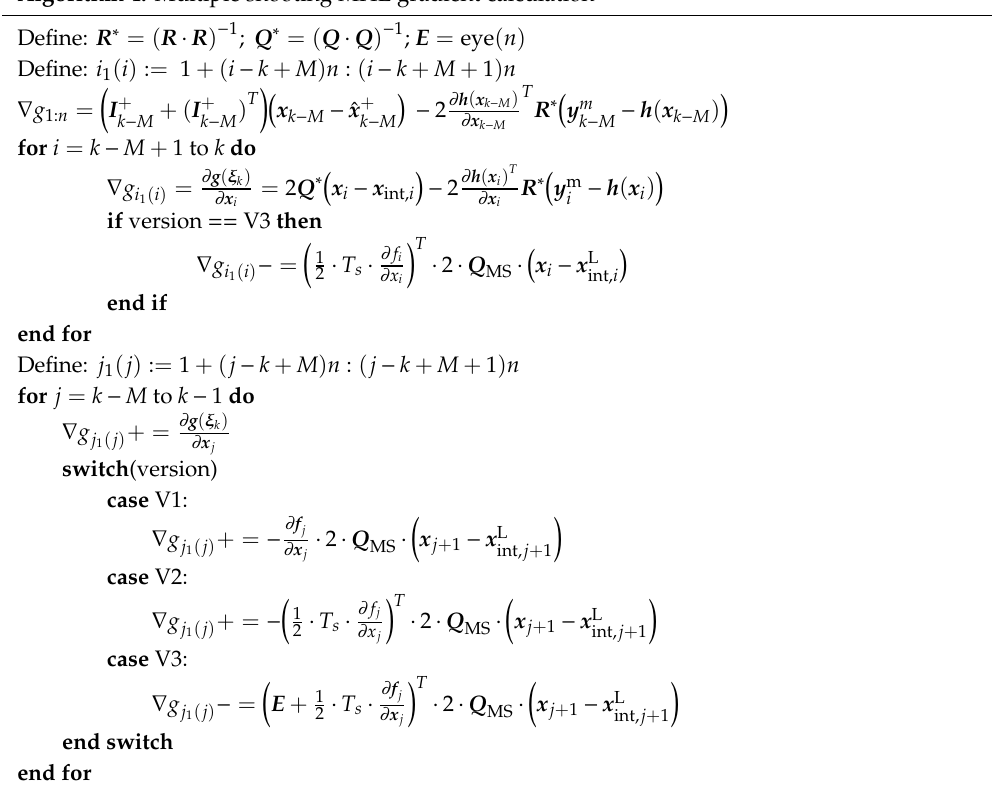
Algorithm 4. Multiple shooting MHE gradient